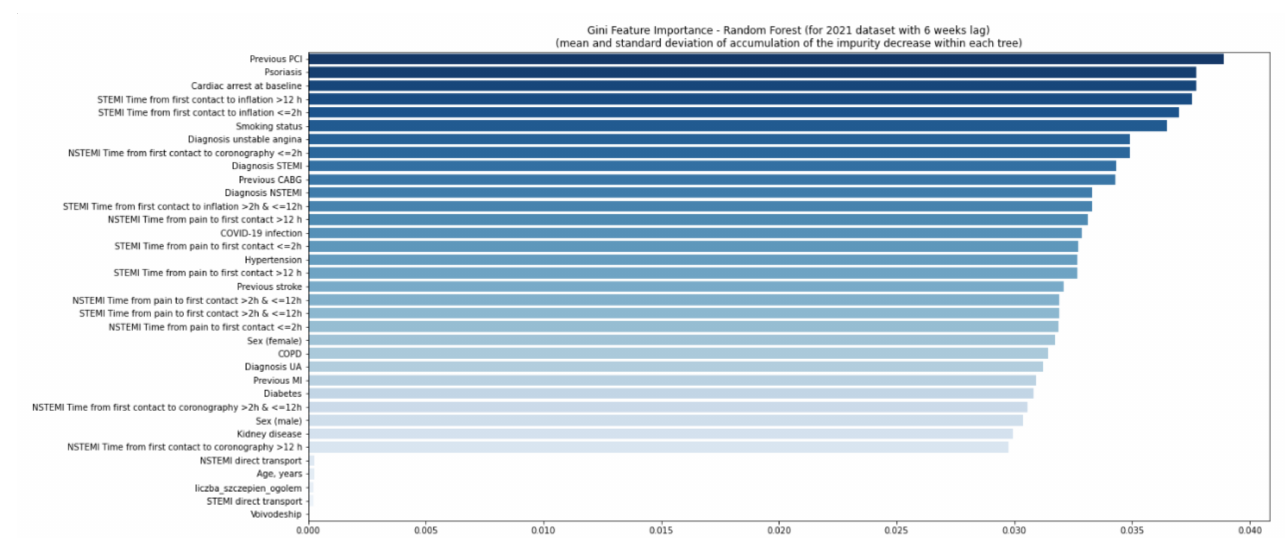
Figure 9. Gini feature importance analysis for patients in 2020 with a six-week lag. The diagram shows the mean decrease of the model’s impurity. In the analysis, each feature’s importance is calculated as the sum over the number of splits across all trees, which includes the feature proportional to the number of samples in the split. In the random forest model, the variable is considered important if the tree split on this variable is affected by large impurity (labels homogeneity in the node) and decreases.